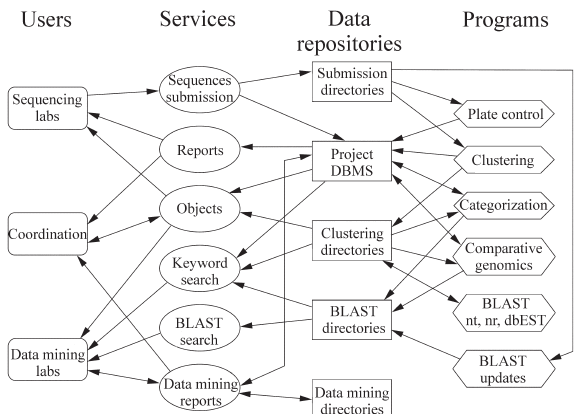
Figure 1 - Major relationships between users, services, data and programs